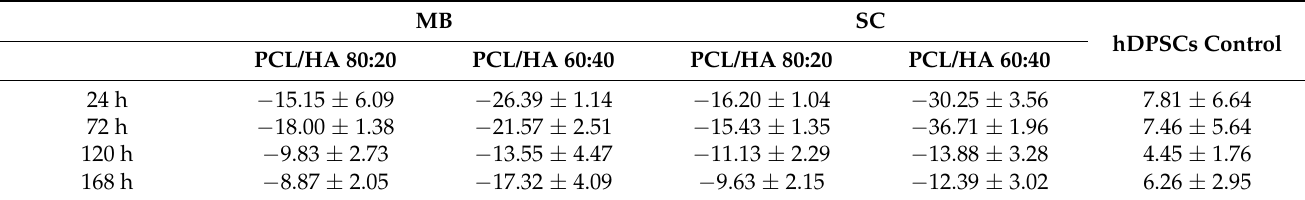
Table 5. Cytocompatibility assessed by Presto Blue TM viability assay for hDPSCs. Results of % viability inhibition are presented in mean ± SE, normalized to the PCL MB as 0%. MB